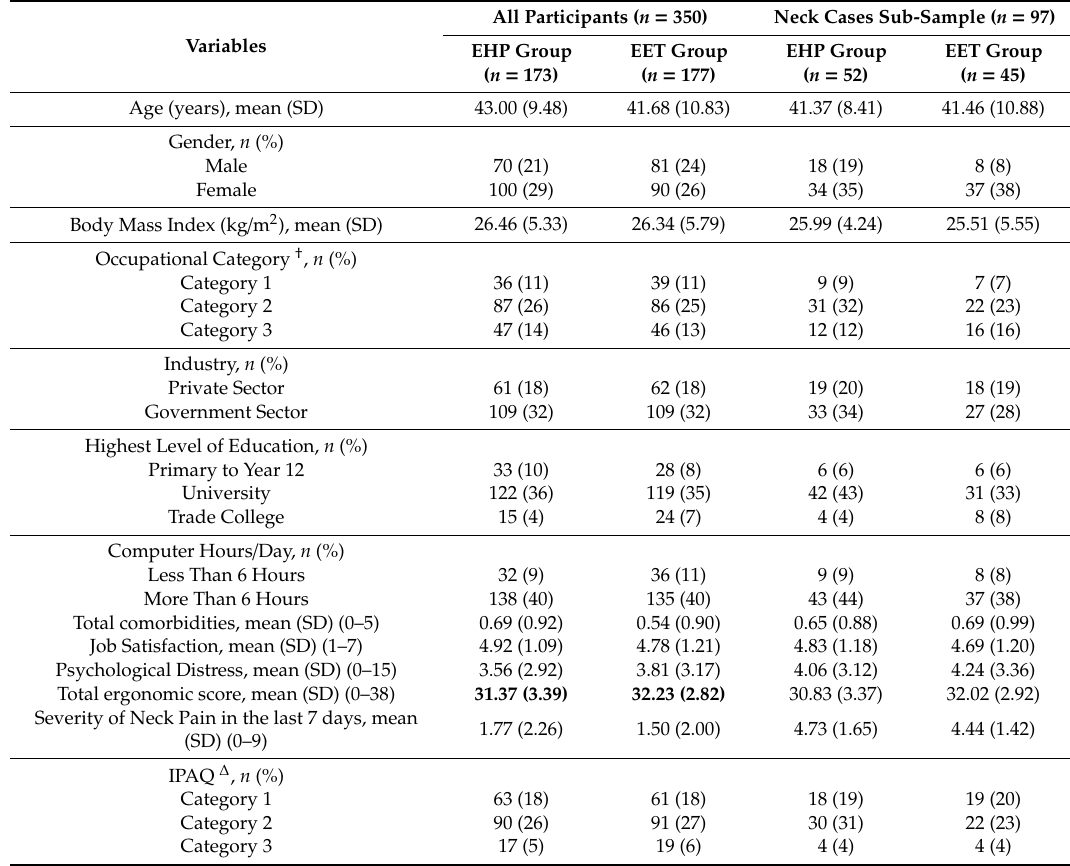
Table 1. Baseline